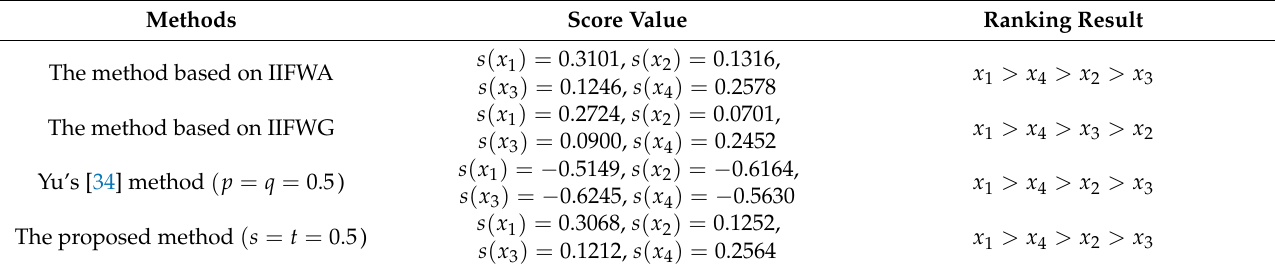
Table 4. Comparison